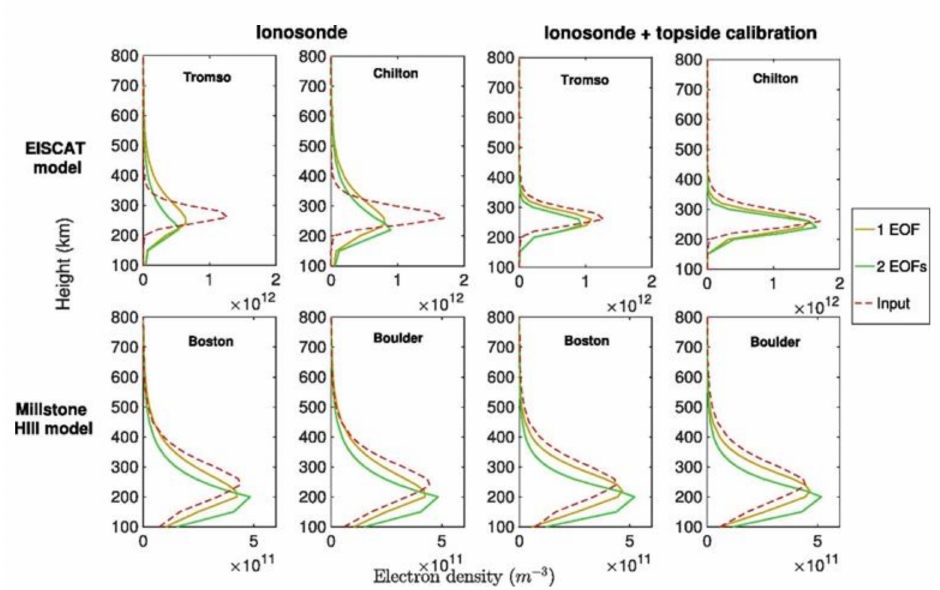
Figure 8. Reconstructed vertical IED profiles in Europe (EISCAT model) and North America (Mill- stone Hill model) obtained using 1 or 2 empirical orthogonal functions (EOFs), compared with the true vertical IED profiles (from [39]). Tromso and Boston are far from the ionosondes, while Chilton and Boulder are located at the ionosondes.